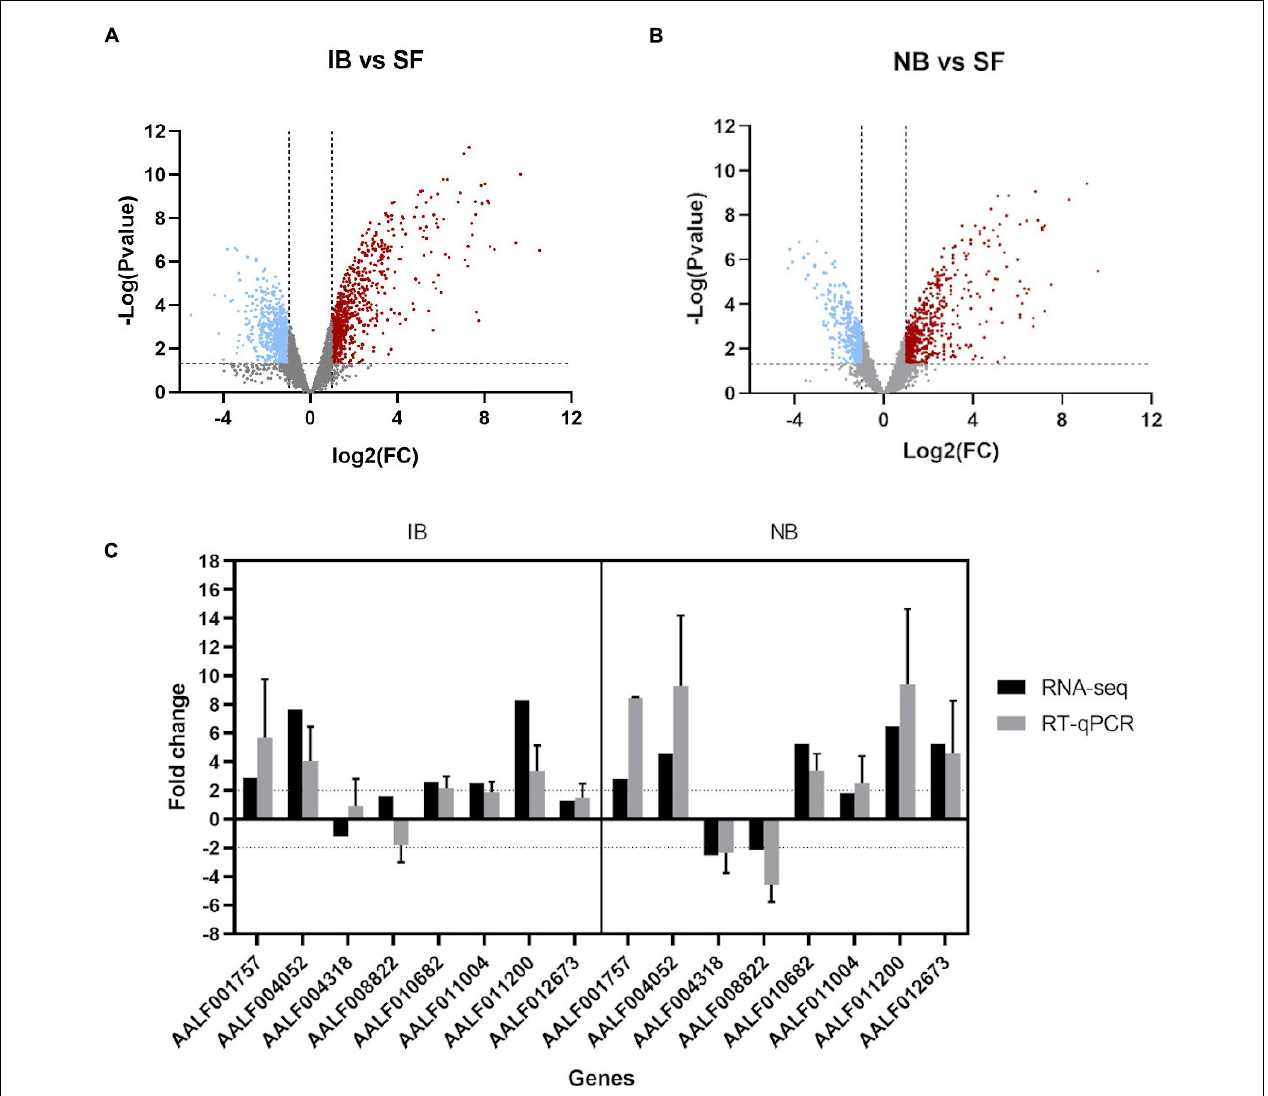
FIGURE 1 | Transcriptome analysis of Ae. albopictus fed with inactivated blood and normal blood. (A) Volcano plots for the differentially expressed genes (DEGs), Inactivated Blood vs. Sugar Fed. Upregulated (red plots) and downregulated (blue plots) DEGs. (B) Volcano plots for the DEGs, Normal Blood vs. Sugar Fed. (C) Fold change of eight immune-related genes expression for RNA-seq and qPCR analysis. qPCR data are presented as FC means ( ± SE) of three technical and three biological replicates.